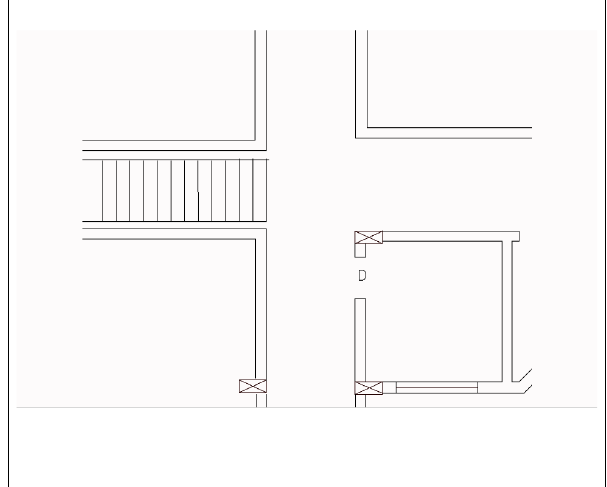
Figure 3: Part of a floor-plan showing a staircase, junction and